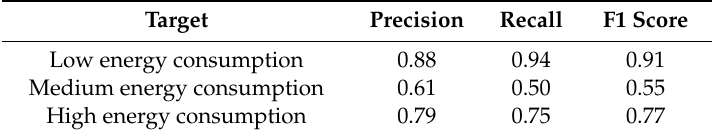
Table 4. Validation results of the indicators in the optimal decision tree model.